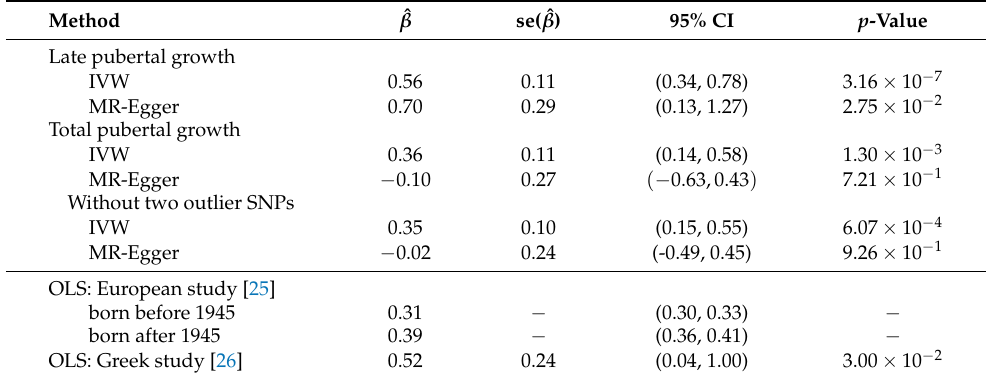
Table 3. Summary of estimates of causal effect β and estimates from previous European and Greek studies. The outcome for the European study and the Greek study is adult height.